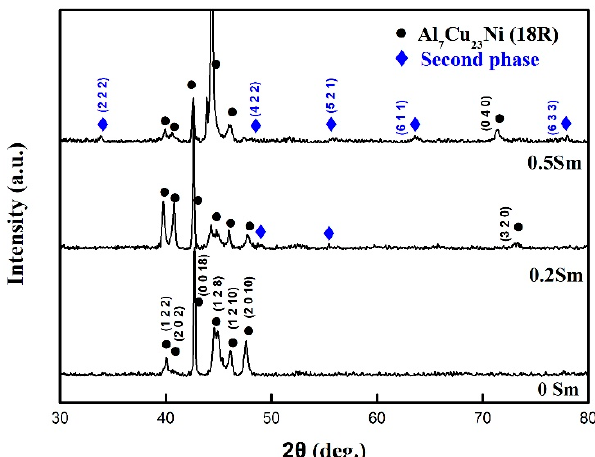
Figure 2. XRD of Cu-13.0Al-4.0Ni- x Sm ( x = 0, 0.2 and 0.5) alloys.